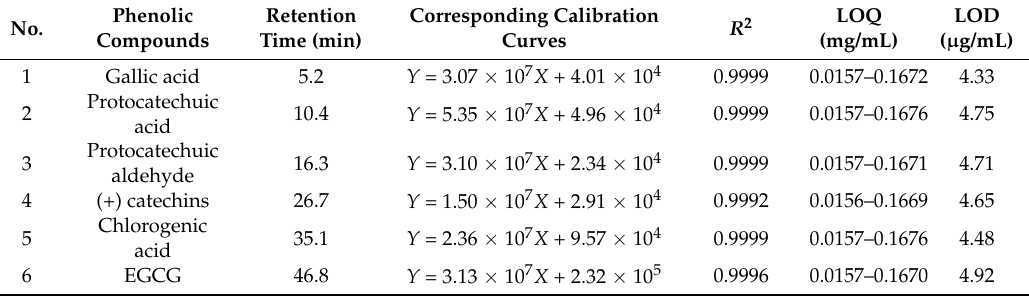
Figure 1. High-performance liquid chromatography (HPLC) of phenolic compounds standards (inner) and Rattan sample (outer). Table 1. Calibration curves and limits of detection for six phenolic compounds.